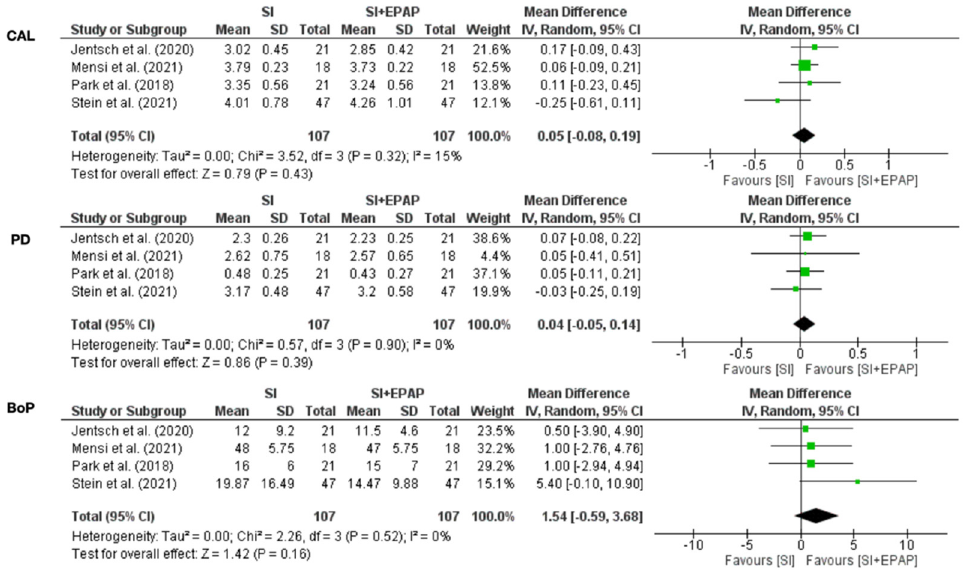
Figure 3. Erythritol in active periodontal therapy.